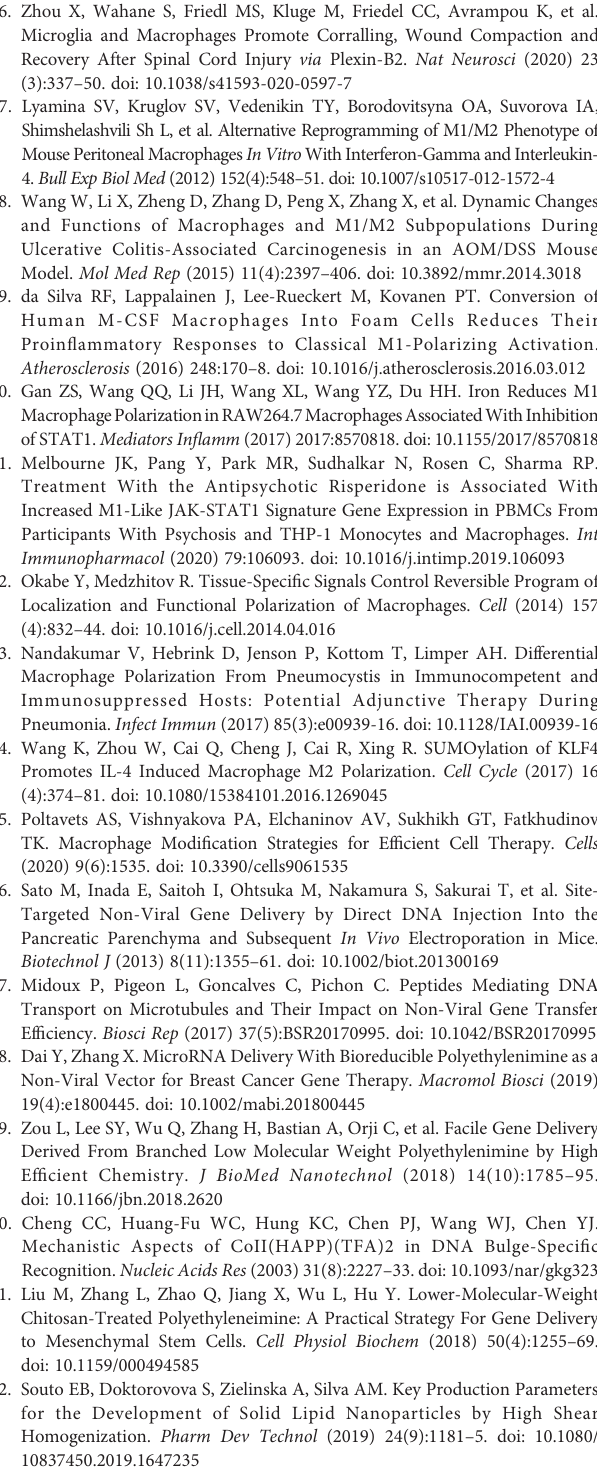
Supplementary Figure 4 | Continuation of IL-4pDNA-NPs transfection in MDM (A) Microscopy imaging of GFP+ MDM illustrated the transfection of IL-4pDNA/ GFP-NPsover25days.(B)FlowcytometryassayshowedtheexpressionofiNOSin MDM response to LPS induced in fl ammation. (C) IL-4pDNA/GFP-NPs transfection